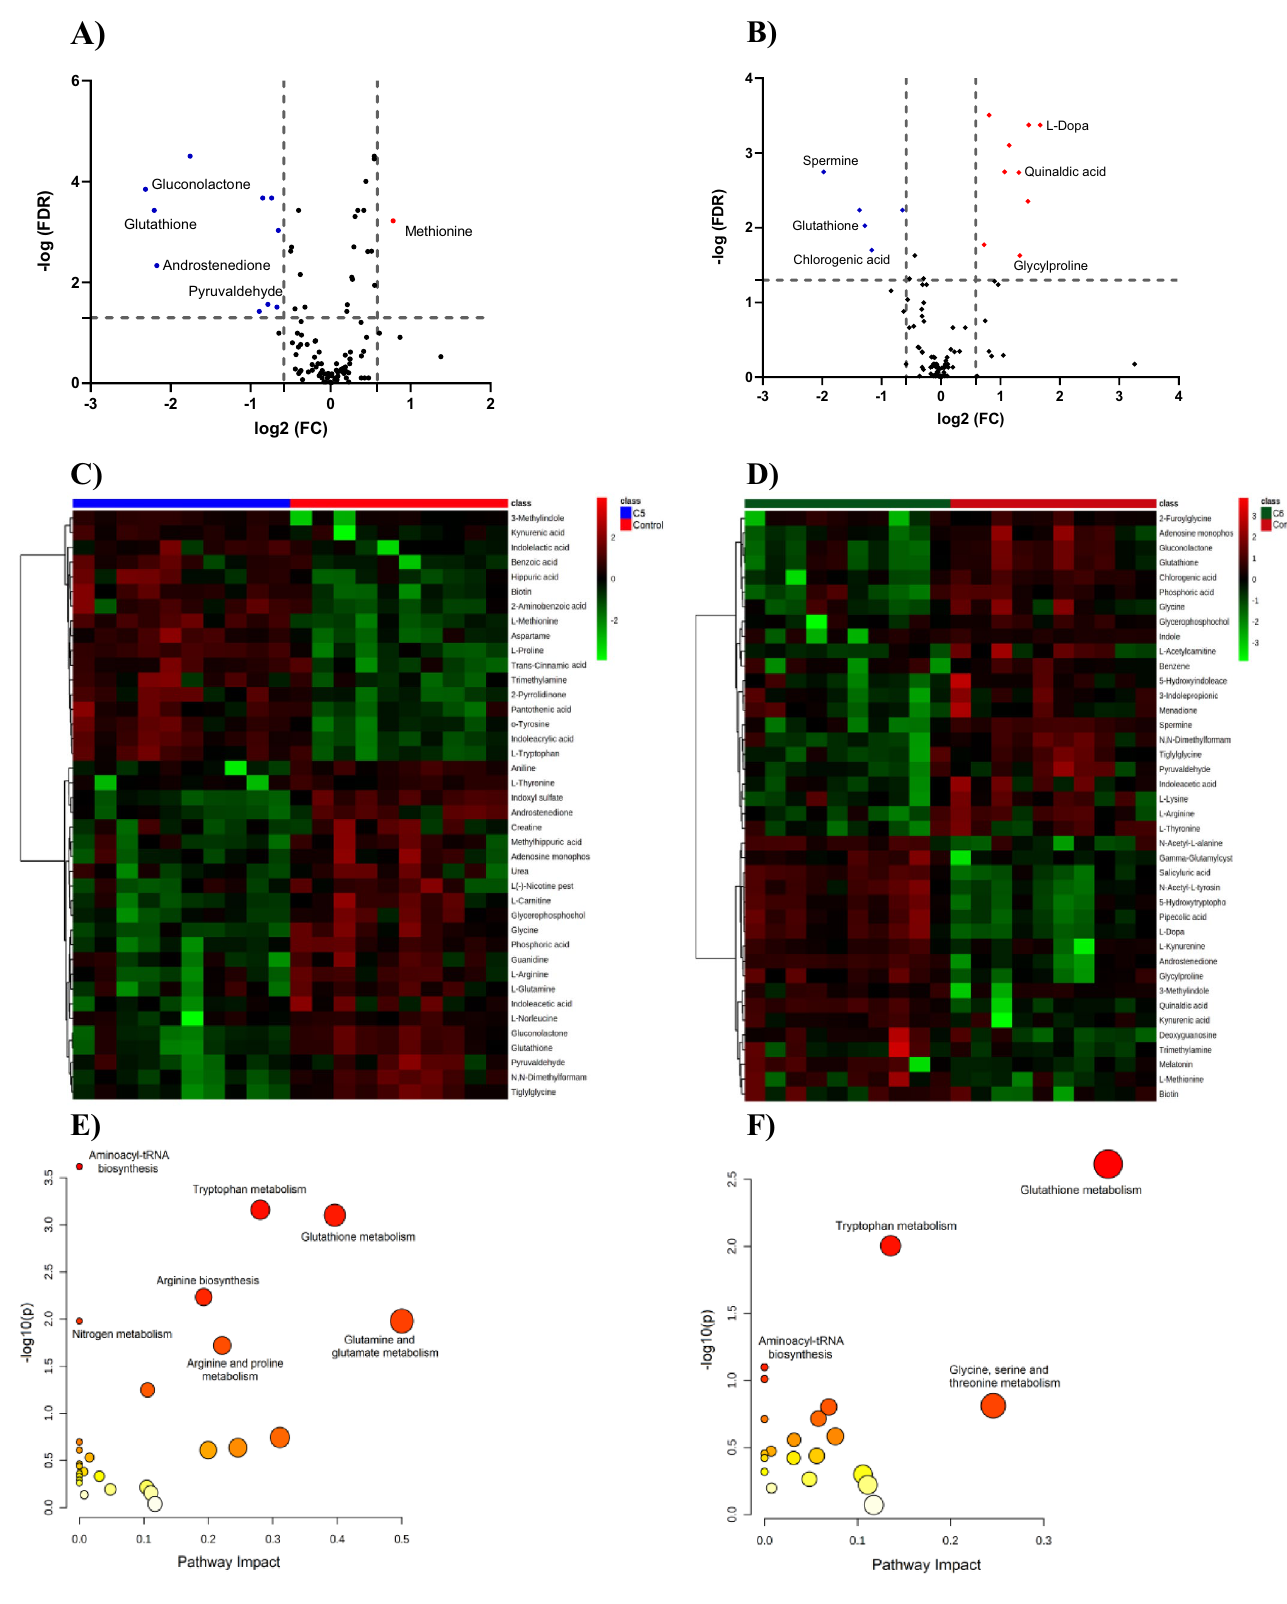
Figure 7. Significantly altered metabolites upon treating DU145 cells with C5 and C6. ( A ) and ( B ) Volcano plots of up (red) and down (blue) regulated metabolites in C5- and C6-treated DU145 cells, respectively, using FDR < 0.05 and FC of 1.5 ( C ) and ( D ) Heatmaps of the level of the top 40 altered metabolites in C5- and C6-treated DU145 cells, respectively. ( E ) and ( F ) Summary of the most affected pathways in C5- and C6-treated DU145 cells, respectively. The node color and size are based on the P- value and the pathway impact value,